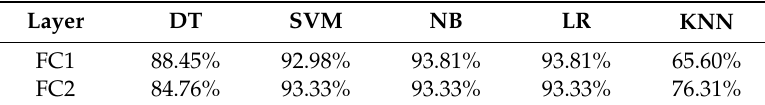
Table 15. Computed recall.